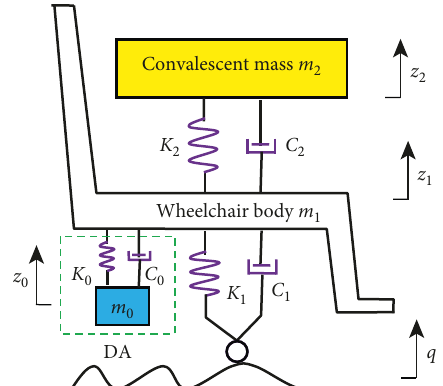
Figure 1: The vibration model of the convalescent-wheelchair system with DA.